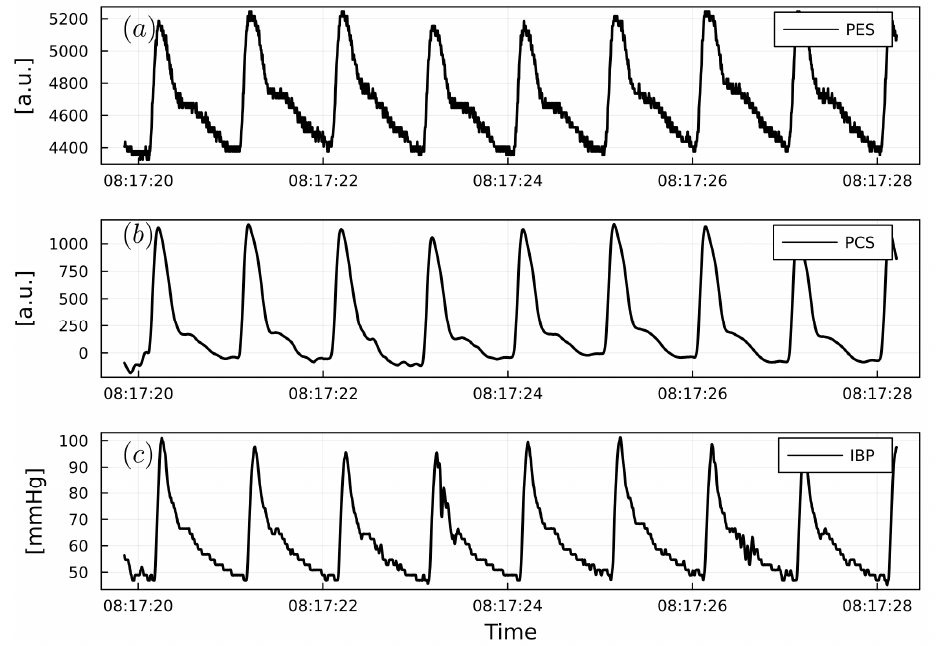
Figure 6. ( a ) Example of PW PES . ( b ) Example of PW PCS . ( c ) Example of PW IBP from a urological surgery patient. PW PES and PW PCS are reported as arbitrary units (a.u.). PW IBP is reported as mmHg.